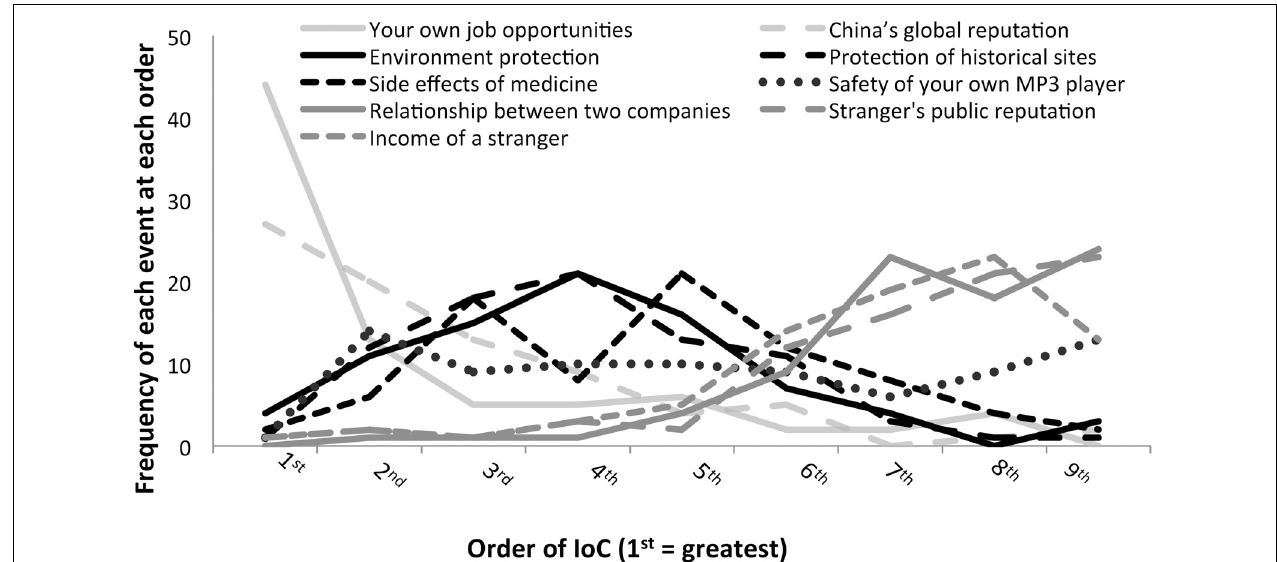
FIGURE 2 | Frequency of reported IoC for all nine critical events.